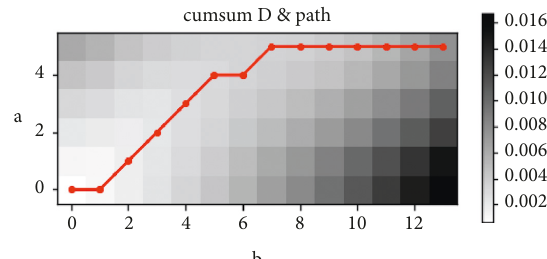
Figure 2: The cumulative local distances and search path diagram of DTW between two series a and b